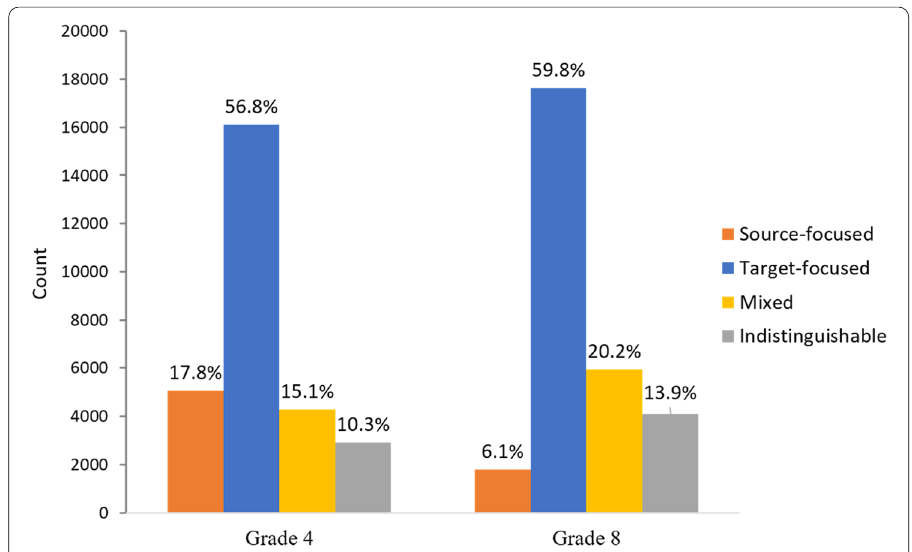
Fig. 4 Number of test‑takers who applied a source‑focused, target‑focused, mixed, or indistinguishable strategy in responding to the fourth‑ and eighth‑grade